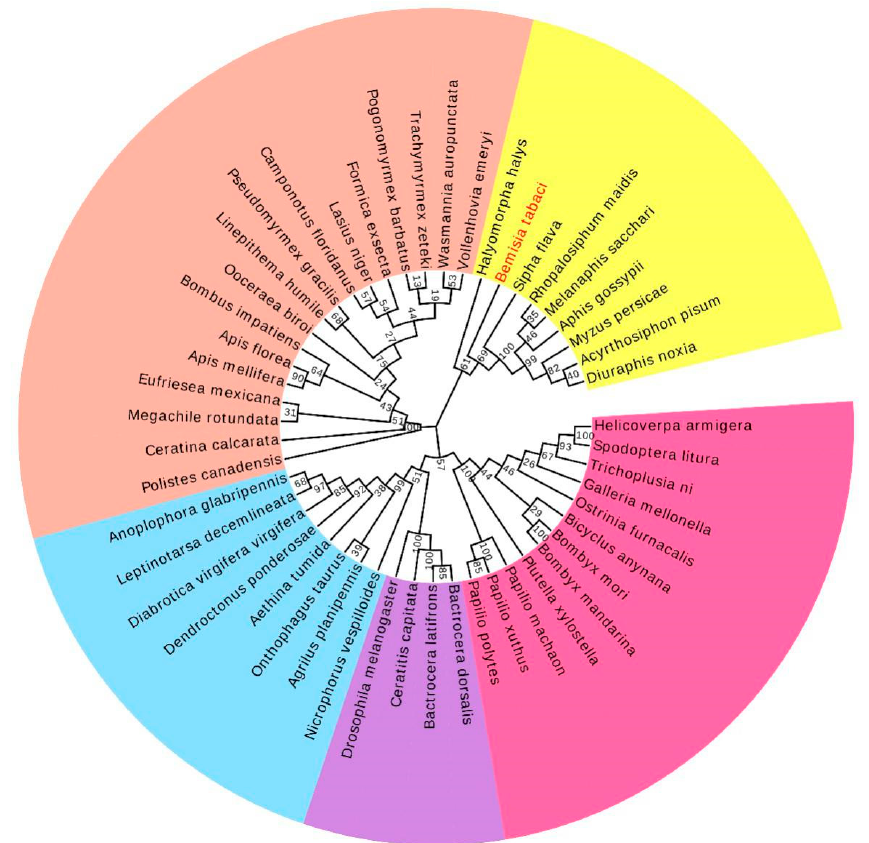
Figure4. AphylogenetictreebasedontheknownaminoacidsequencesofISWIgenes. Thephylogenetic Figure 4. A phylogenetic tree based on the known amino acid sequences of ISWI genes. The tree was constructed using the maximum likelihood method with 1000 bootstrap replications in MEGA phylogenetic tree was constructed using the maximum likelihood method with 1000 bootstrap 7.0 software. Numbers at the nodes of the branches represent the level of bootstrap support for each replications in MEGA 7.0 software. Numbers at the nodes of the branches represent the level of branch. Insects in the same order clustered on the same branch. Lepidoptera is depicted in pink, bootstrap support for each branch. Insects in the same order clustered on the same branch. Diptera in purple, Coleoptera in baby blue, Hymenoptera in dusty pink, and Hemiptera in yellow. Lepidoptera is depicted in pink, Diptera in purple, Coleoptera in baby blue, Hymenoptera in dusty Table S1 shows the ISWI protein sequences used for phylogenetic pink, and Hemiptera in yellow. Table S1 shows the ISWI protein sequences used for phylogenetic analysis.